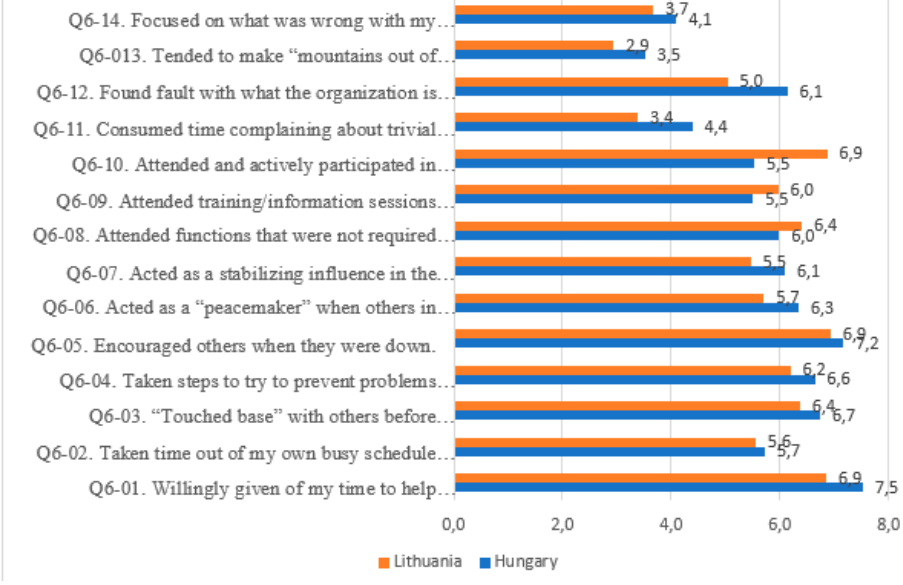
Figure 2. Average responses to the section Q6 questions about OCB and CWB (see Appendix A).